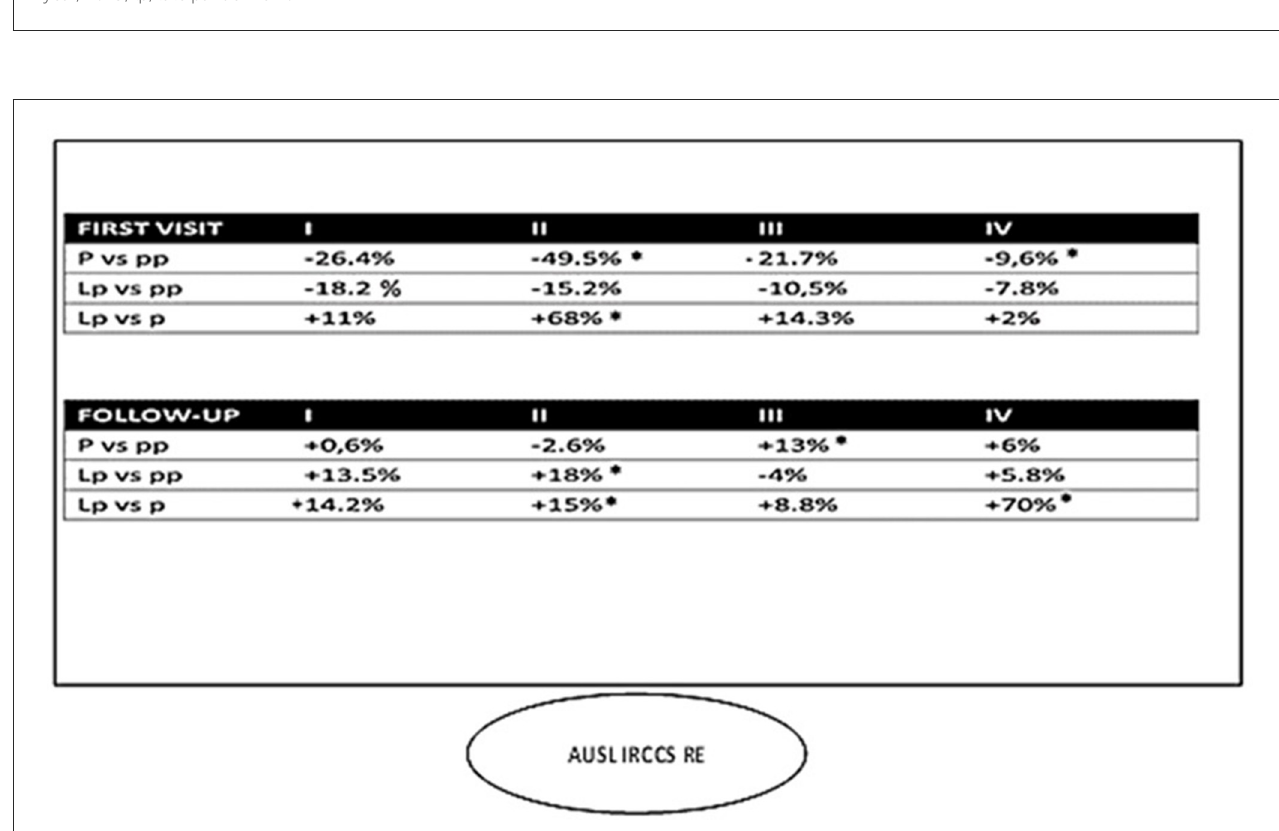
FIGURE3 Percentages of visit volume for first appointments and follow-ups of outpatients for each oncological center. p, pandemic year, 2020; pp, pre-pandemic year, 2019; lp, late pandemic 2021.